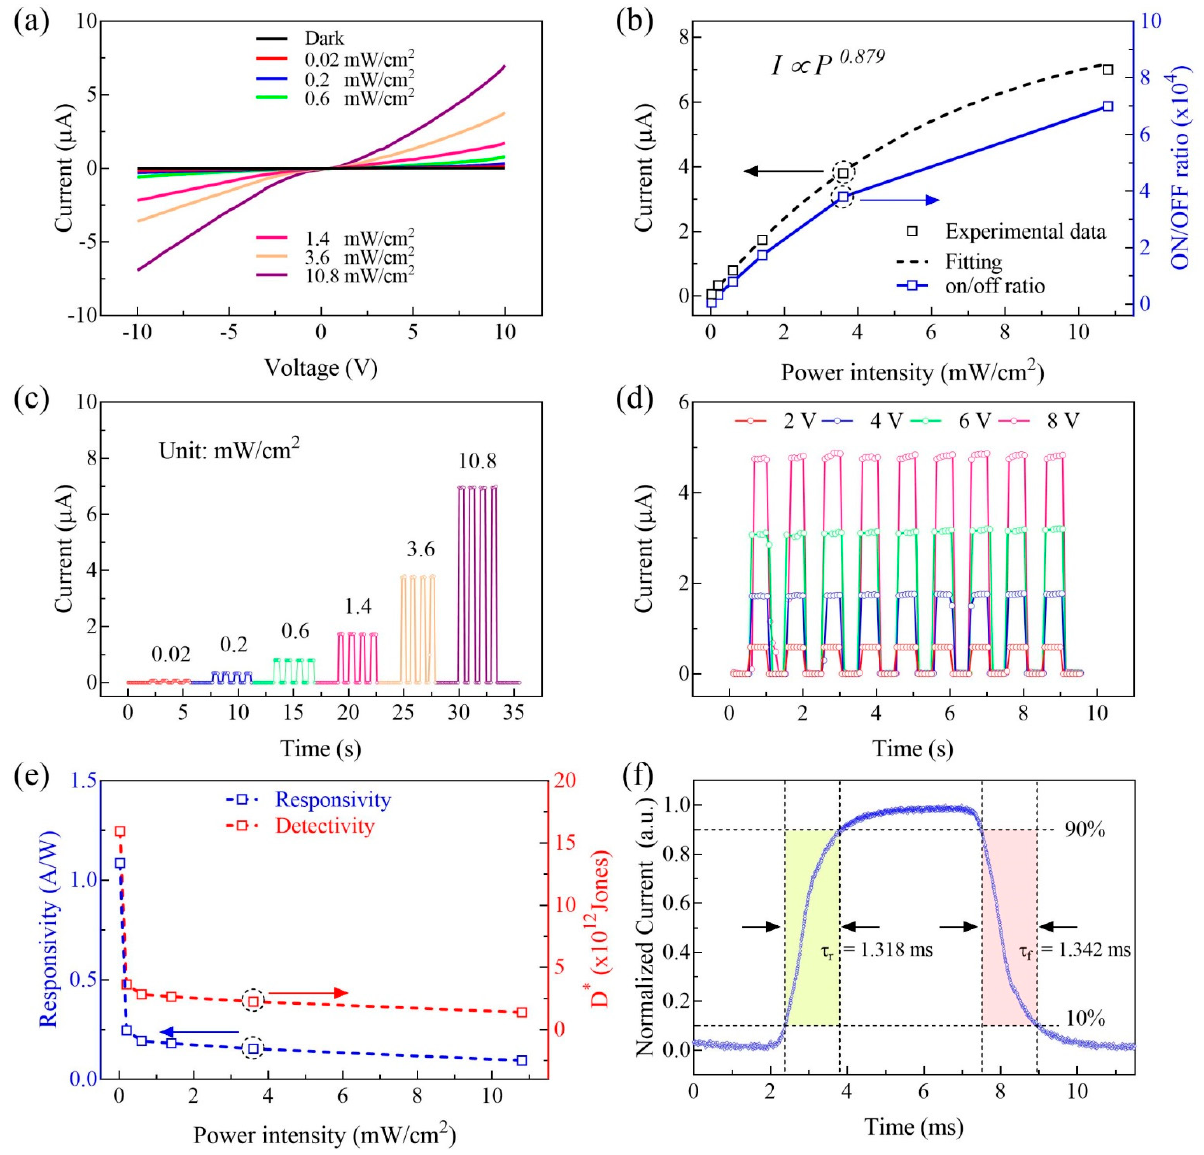
Figure 4. ( a ) I-V characteristics of the C-dot/CsPbBr 3 perovskite photodetector in the dark and under 520 nm illumination with different intensities. ( b ) Photocurrent and on/off ratio as a function of light intensity at 10 V. ( c ) I-T curves of the photodetector under 520 illuminations with different intensities. ( d ) I-T curves of the photodetector under 520 nm light illumination with a 10.8 mW/cm 2 light intensity at different bias voltages. ( e ) R and D* of the photodetector under 520 nm light illumination as a function of incident power intensity. ( f ) Response time of the photodetector.